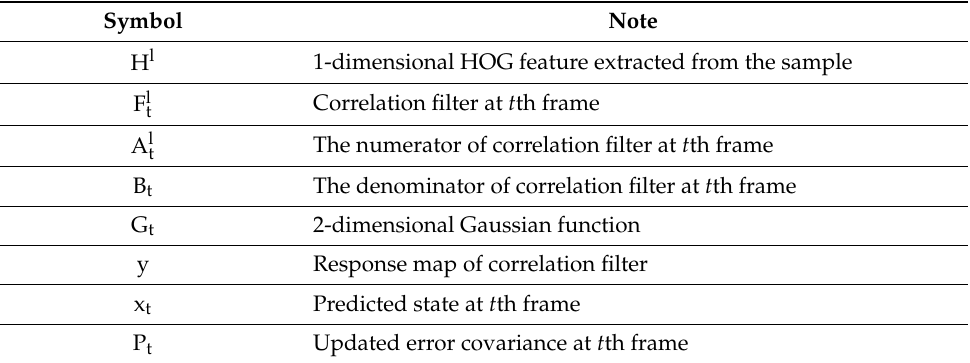
Table 1. List of